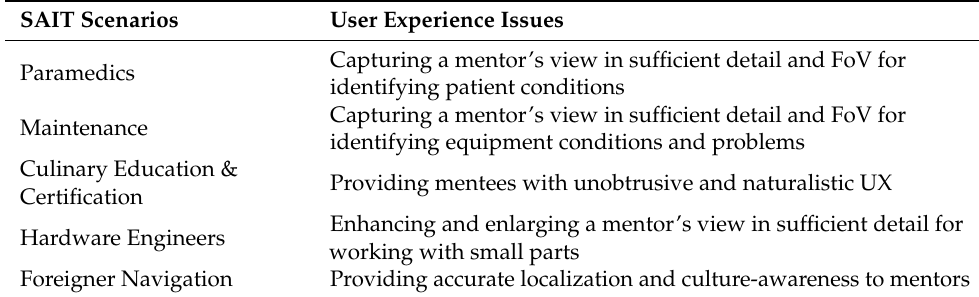
Table 7. User experience issues in SAIT scenarios.